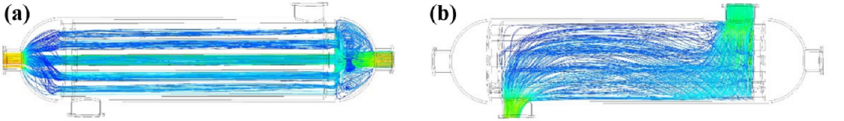
Figure 14. Streamline distribution diagram inside the superheater. ( a ) Steam flow line on the tube side. ( b ) Molten salt flow line on the shell side.